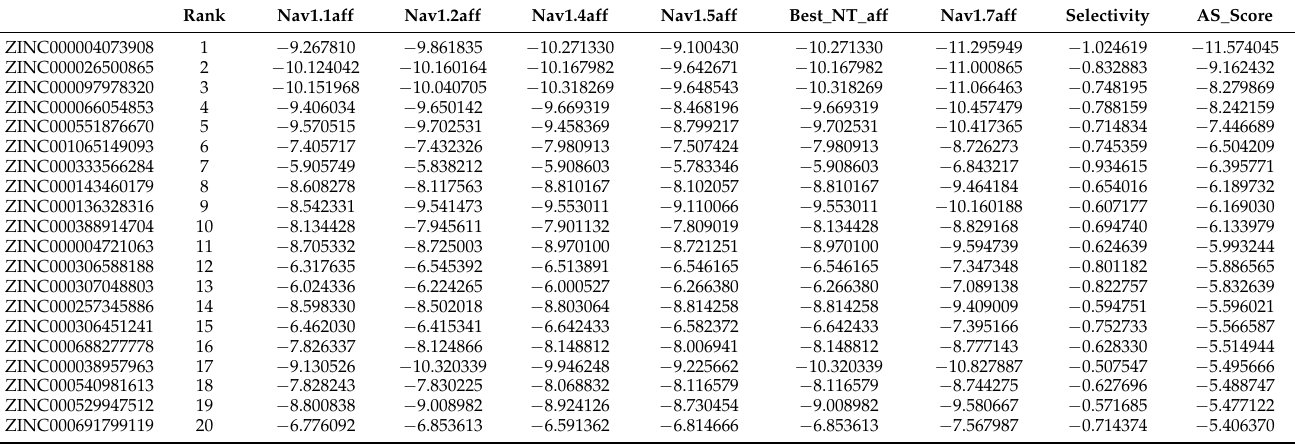
Table 1. Final virtual screening results. Measurement units for columns 3 to 9 are kcal/mol, last column is in kcal 2 /mol 2 . Columns 3–6 report the affinity values of the compounds against the Negative Targets Nav1.1, Nav1.2, Nav1.4, Nav1.5; Column 8 is the affinity value of the compounds